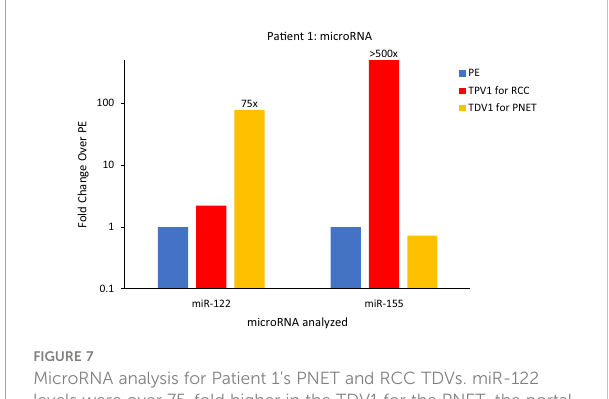
FIGURE 7 MicroRNA analysis for Patient 1 ’ s PNET and RCC TDVs. miR-122 levels were over 75-fold higher in the TDV1 for the PNET, the portal vein (PV, in yellow) compared to a peripheral sample (PE, in blue) (all 2500P fraction). The TPV1 for the RCC, the right renal vein (RRV, in red) had over 500-fold higher levels of miR-155 over PE (all 110kP fraction). The y-axis is on a log